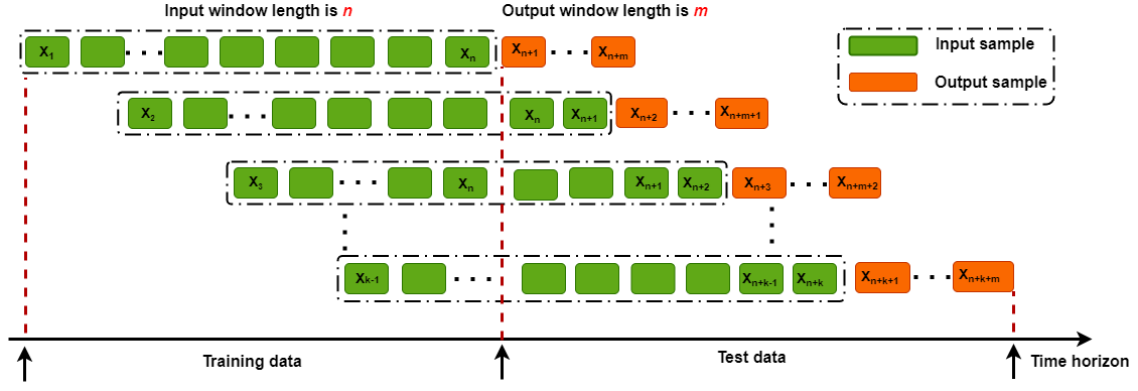
Figure 4. Sliding-window